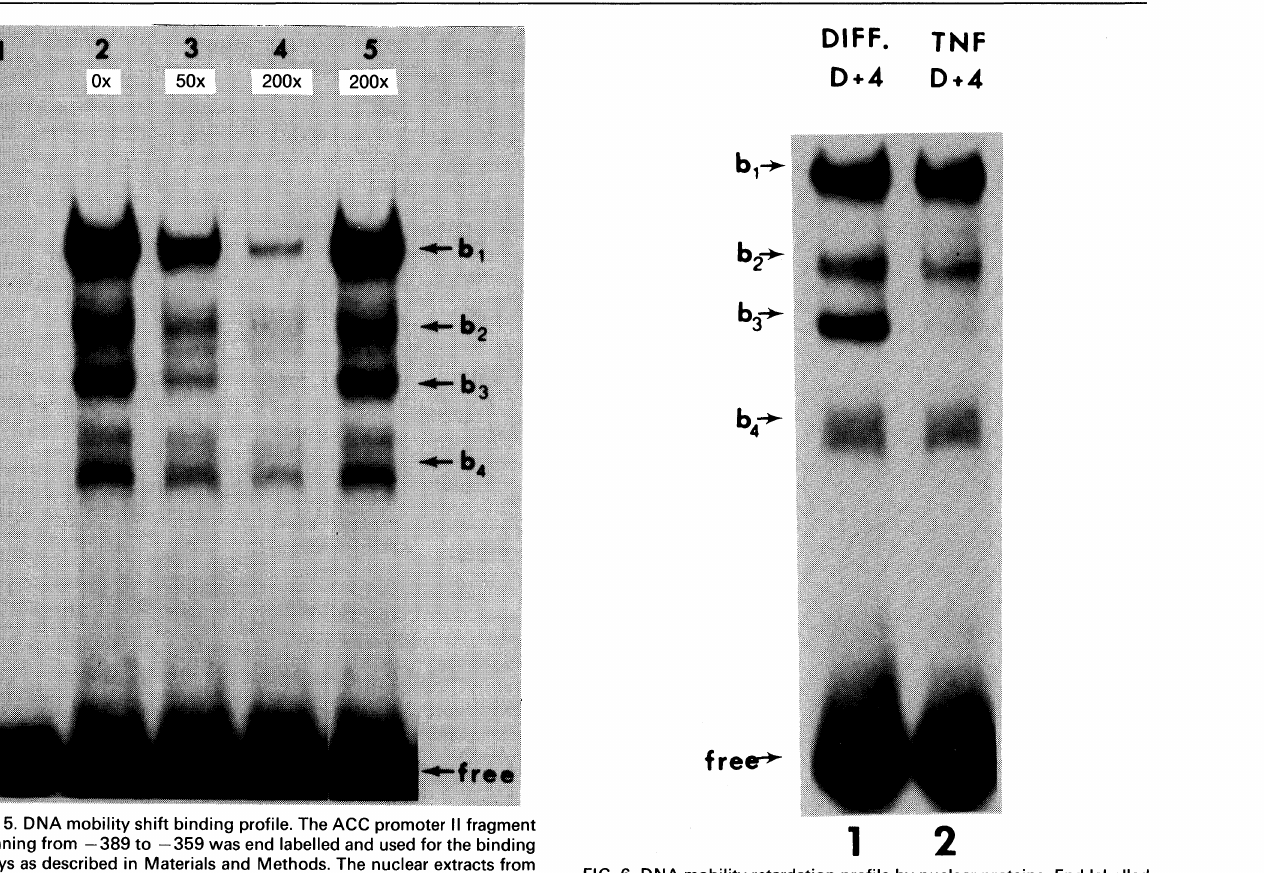
FIG. 6. DNA mobility retardation profile by nuclear proteins. End labelled 30-mer probe (-389 to -359), (0.2 ng), was incubated in the presence of nuclear proteins (10 #g) on ice for 30 min. The mobility of the retarded probe DNA was analysed through a 4% polyacrylamide gel as described in Materials and Methods. Lanes and 2, labelled DNA (-389/-359) in the presence of the nuclear proteins from differentiated 30A5 cells (D+4) and 30A5 cells treated with TNF for the same period of time